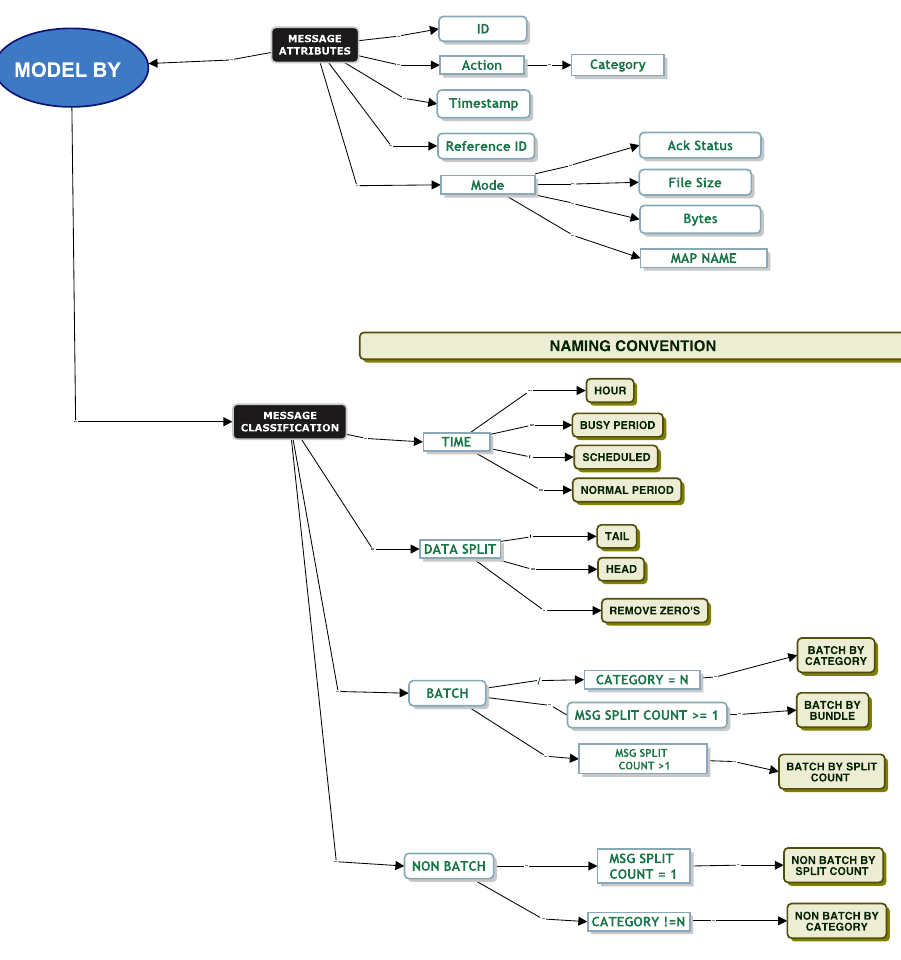
Figure 5. Message